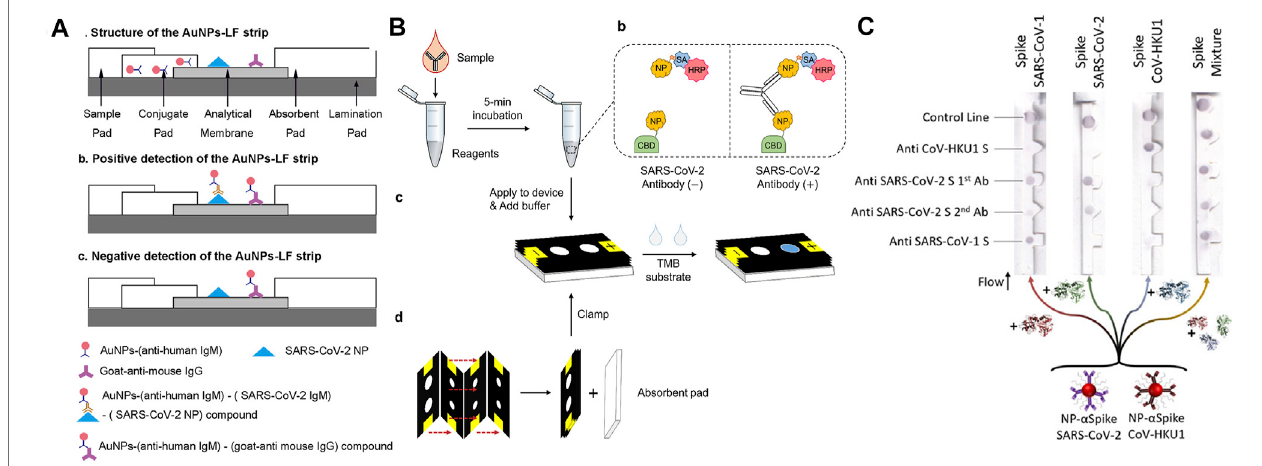
FIGURE 3 | (A) Lateral fl ow paper-based antibody test. Adapted with permission from (Huang et al., 2020), under ACS Author Choice License; (B) antibody test using a μ PAD. Adapted with permission from (Kim et al., 2021), copyright American Chemical Society 2021; (C) lateral fl ow paper-based antigen test. Adapted with permission from (Hristov et al., 2021) copyright American Chemical Society